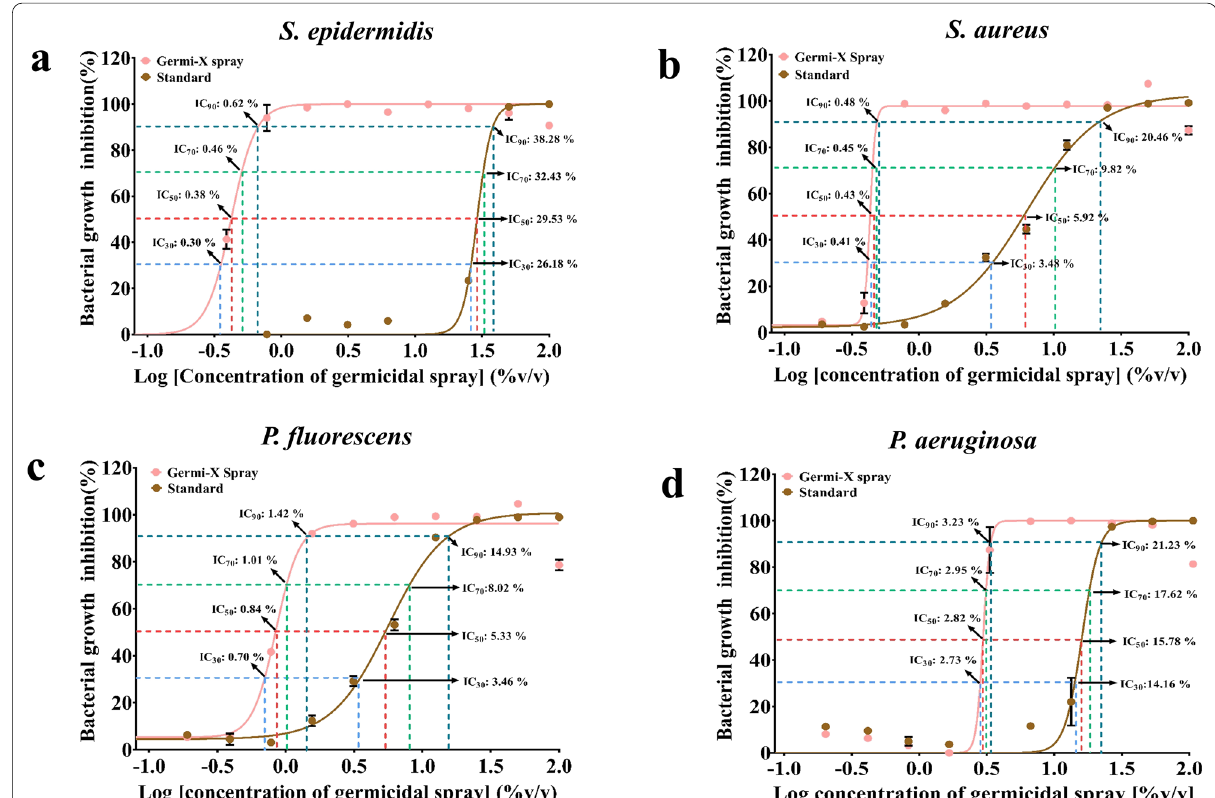
Fig. 3 Germicidal potency of Germi-X spray. a – d Dose–response curves showing dose-dependent inhibitory effect of Germi-X spray and standard on the growth of S. epidermidis ( a ), S. aureus ( b ), P. fluorescens ( c ) and P. aeruginosa ( d ) Concentrations responsible for 30 (IC 30 ), 50 (IC 50 ), 70 (IC 70 ) and 90 (IC 90 ) % growth inhibitions, as determined through non-linear regression analysis, are mentioned